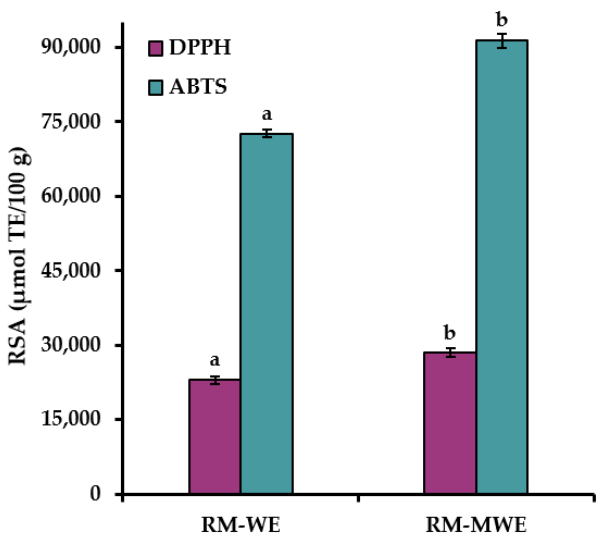
Figure 3. Radical scavenging activity of RM extracts determined by DPPH and ABTS methods. Bars with different letters (a, b) represent statistical differences (one-way ANOVA and Duncan test, p < 0.05) between radical scavenging activity of RM-WE and